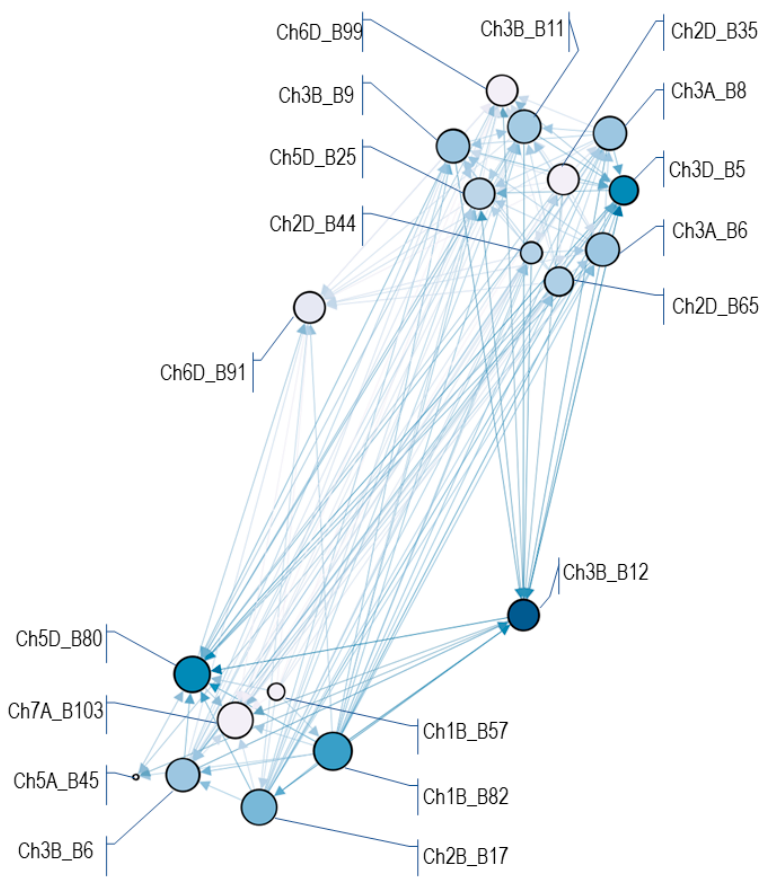
Figure 6. Network prepared from GWAS results obtained from FHB resistance data and DArTseq genotyping of wheat family panel using the association weight matrix and partial correlation–information theory approaches. Nodes represent 19 haploblocks and edges represent significant correlations between HBs. Colors of the nodes indicate influential nodes for the highest value.